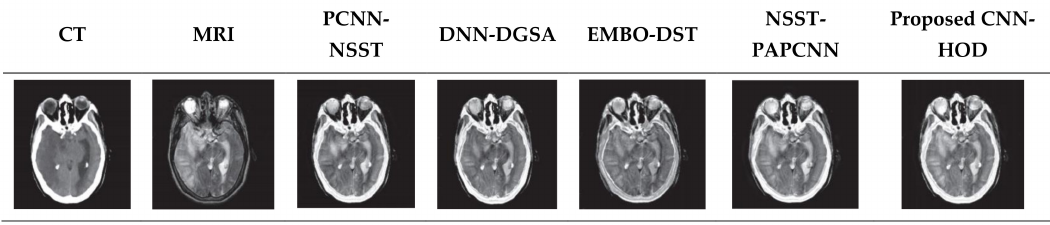
Figure 5. Fusion results of CT and MRI.